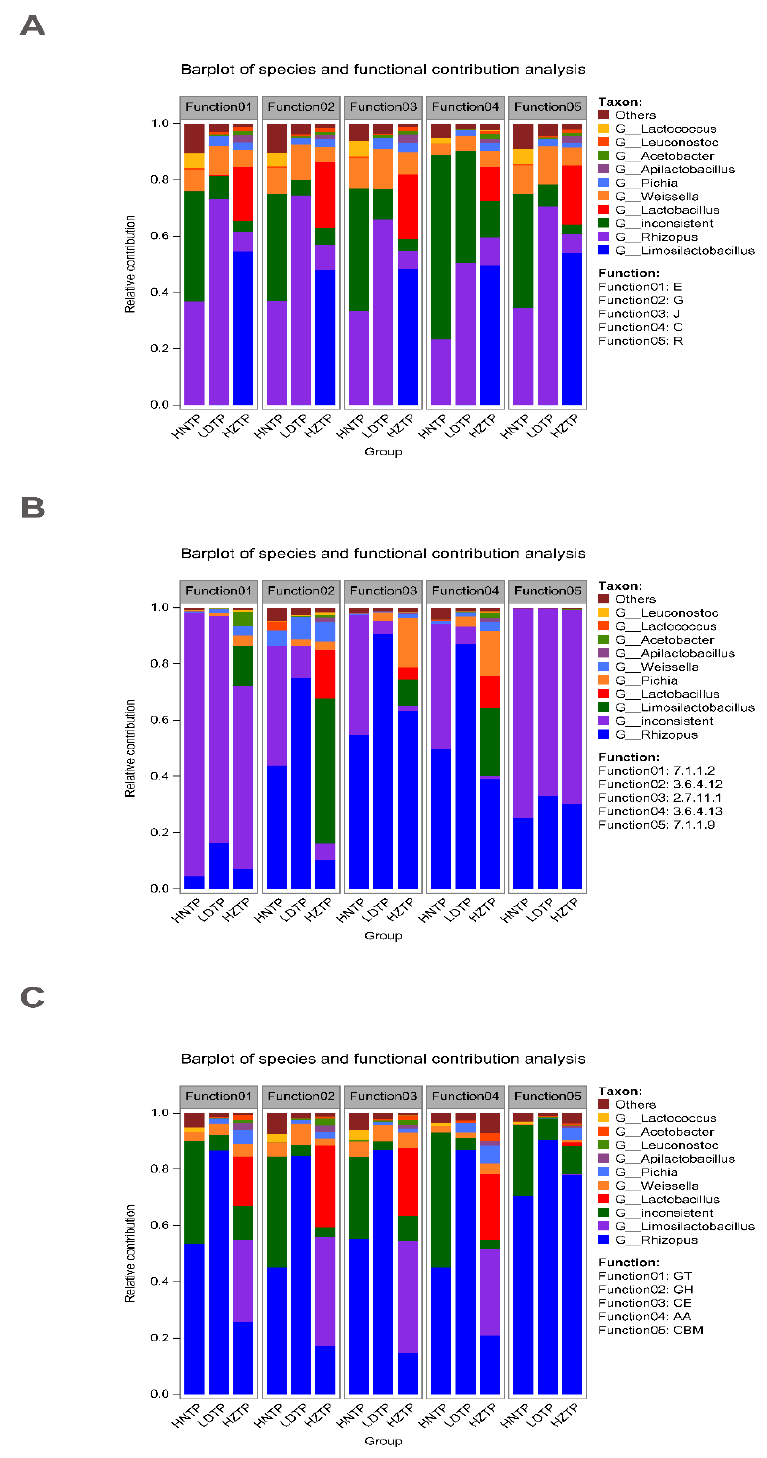
Figure 4. Taxa and function contribution analysis of Tianpei samples: ( A ) taxa and COG contribu- tion, ( B ) taxa and KEGG contribution, ( C ) taxa and CAZy contribution. ( B ) taxa and KEGG contribution, ( C ) taxa and CAZy